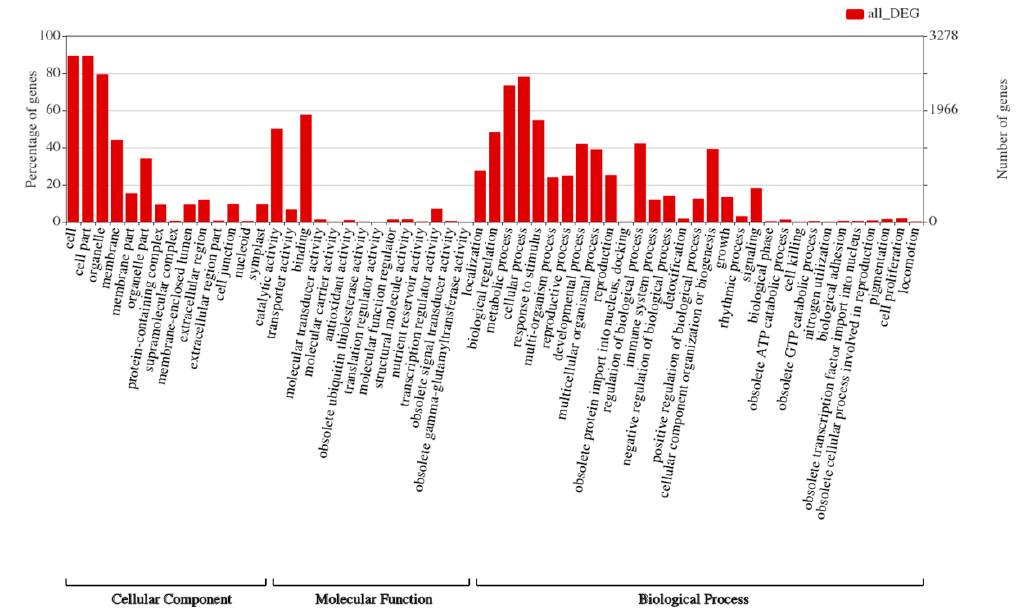
Figure 7. Enrichment of GO classification of 3559 differentially expressed genes.